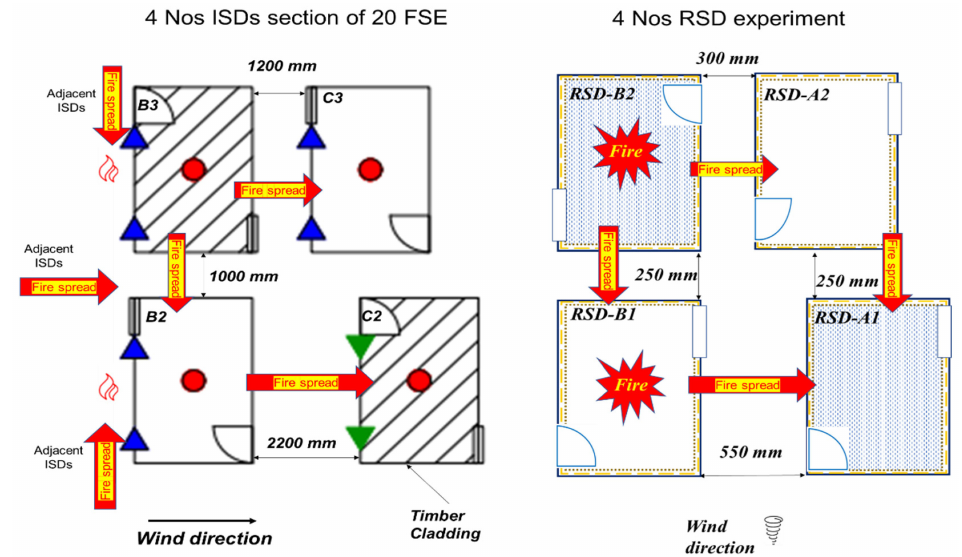
Figure 12. Fire spread in FSEs and 4 Nos RSD test.